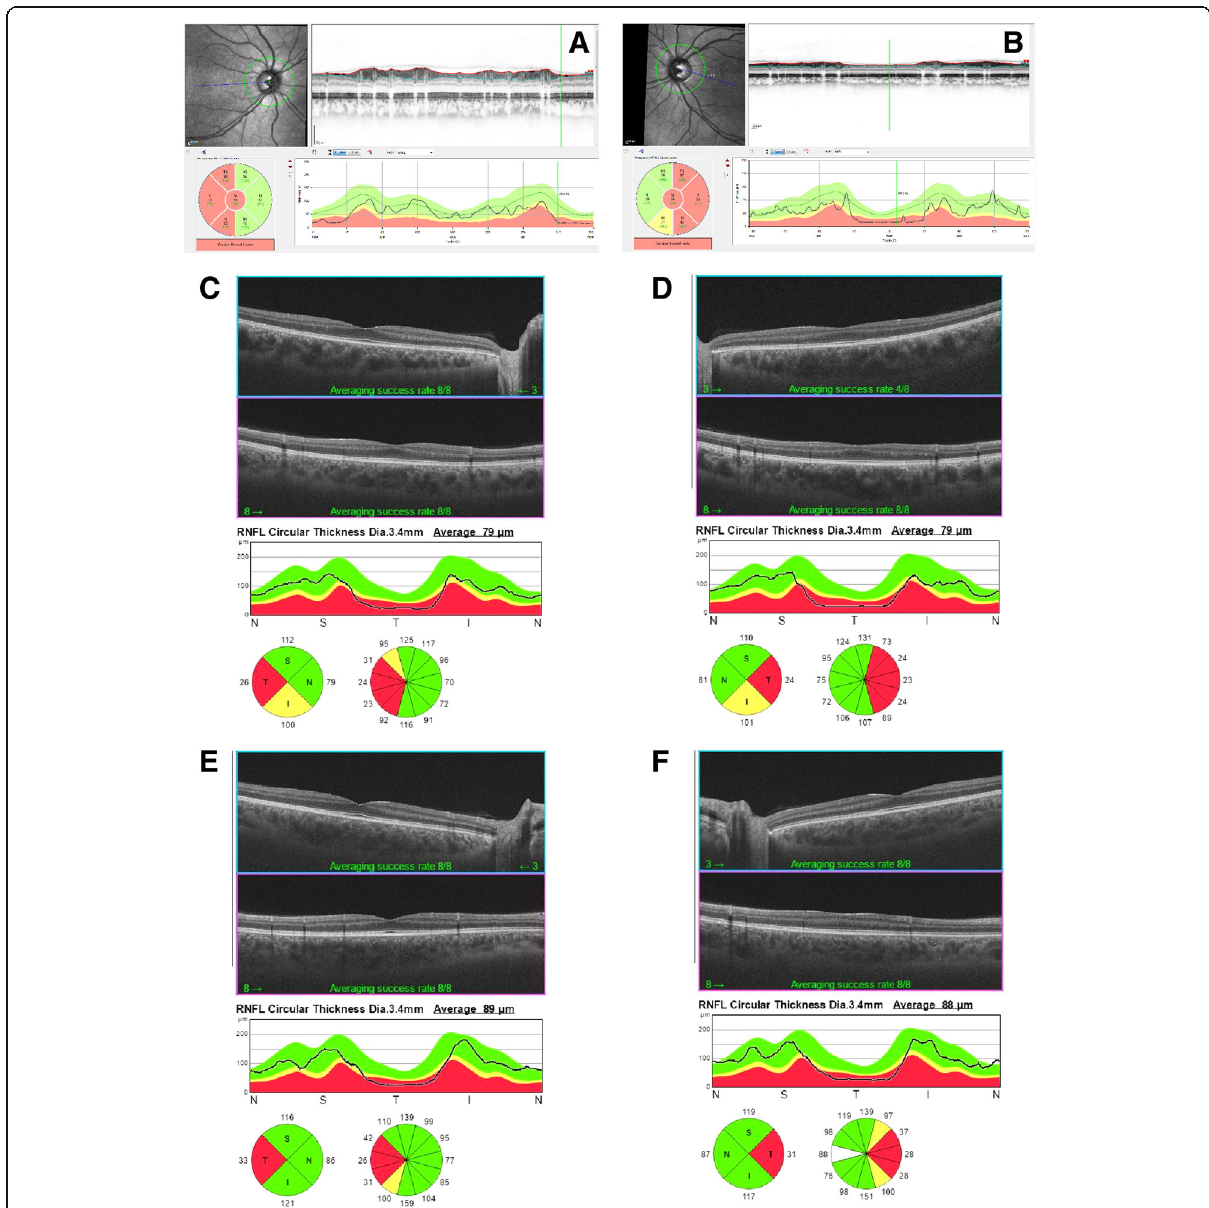
Fig. 3 Optical coherence tomography (OCT) of the retinal nerve fiber layers (RNFLs). ( a - b ) The right eye ( a ) and left eye ( b ) OCT of the affected proband in family A (II:1) show temporal thinning of RNFLs. This can also be seen in the affected sister ( c - d ; II:1) and her brother ( e - f ; II:2) of family